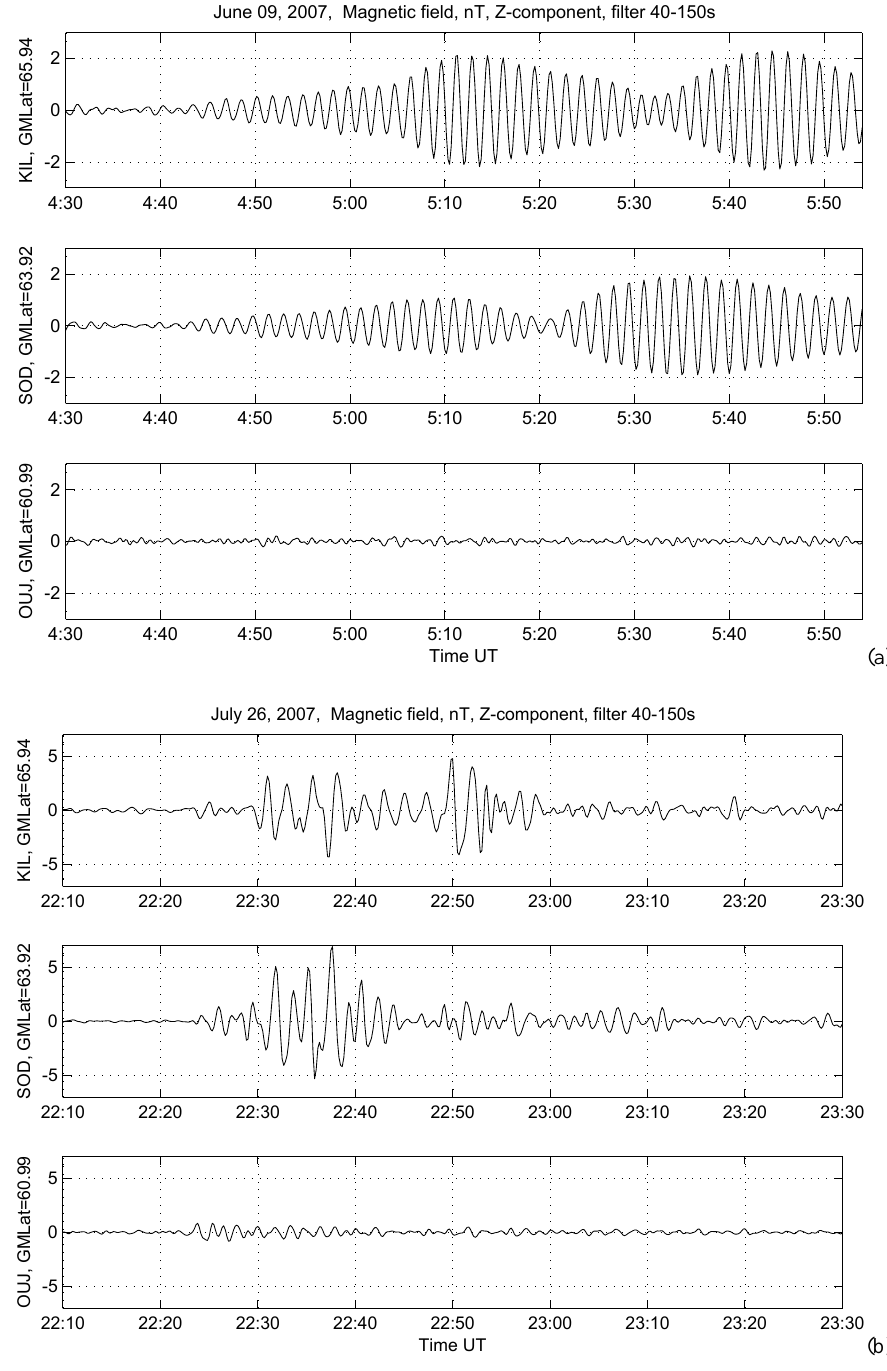
Fig. 8. (a) Geomagnetic pulsations recorded by the IMAGE magnetometers in northern Finland (only Z -component is shown). Example of Pc4 pulsations on 9 June 2007. (b) Same as (a) but for the example of Pi2 pulsations on 26 July 2007.